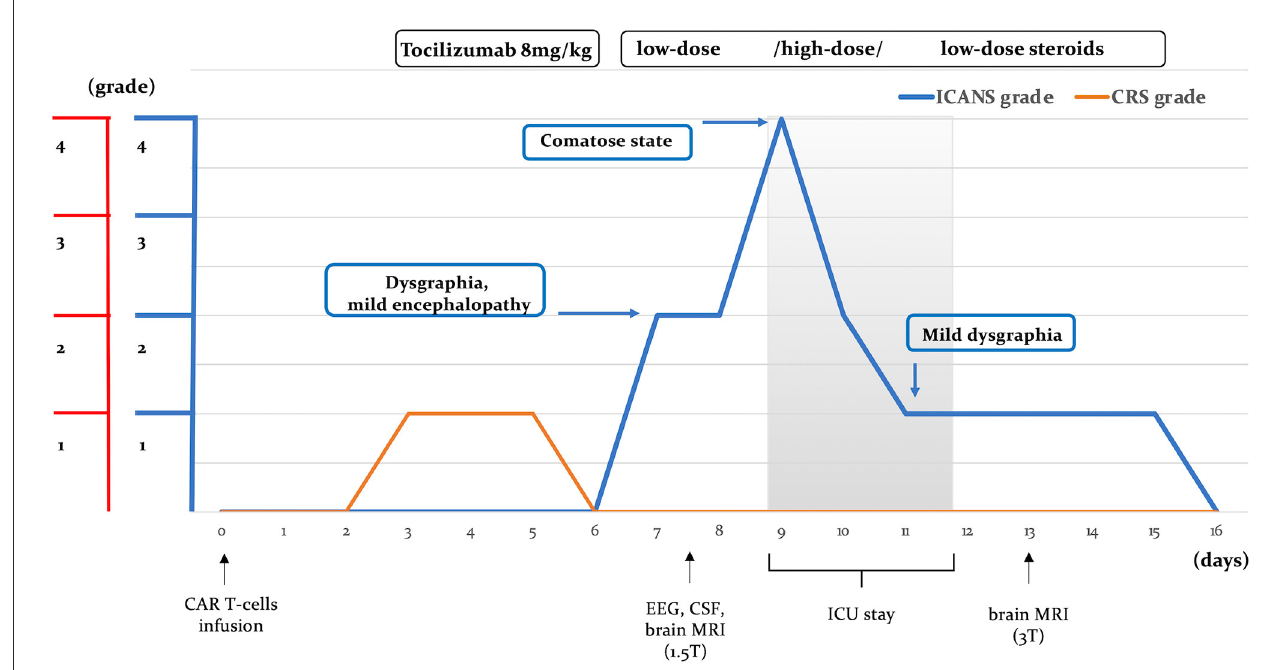
FIGURE1 Disease course. Clinical manifestations of neurotoxicity, CRS, and ICANS severity, along with the timing of diagnostic investigations and treatment following CAR T-cell therapy, are illustrated. CRS, cytokine release syndrome; ICANS, immune effector-associated neurotoxicity syndrome; CSF, cerebrospinal fluid; ICU, intensive care